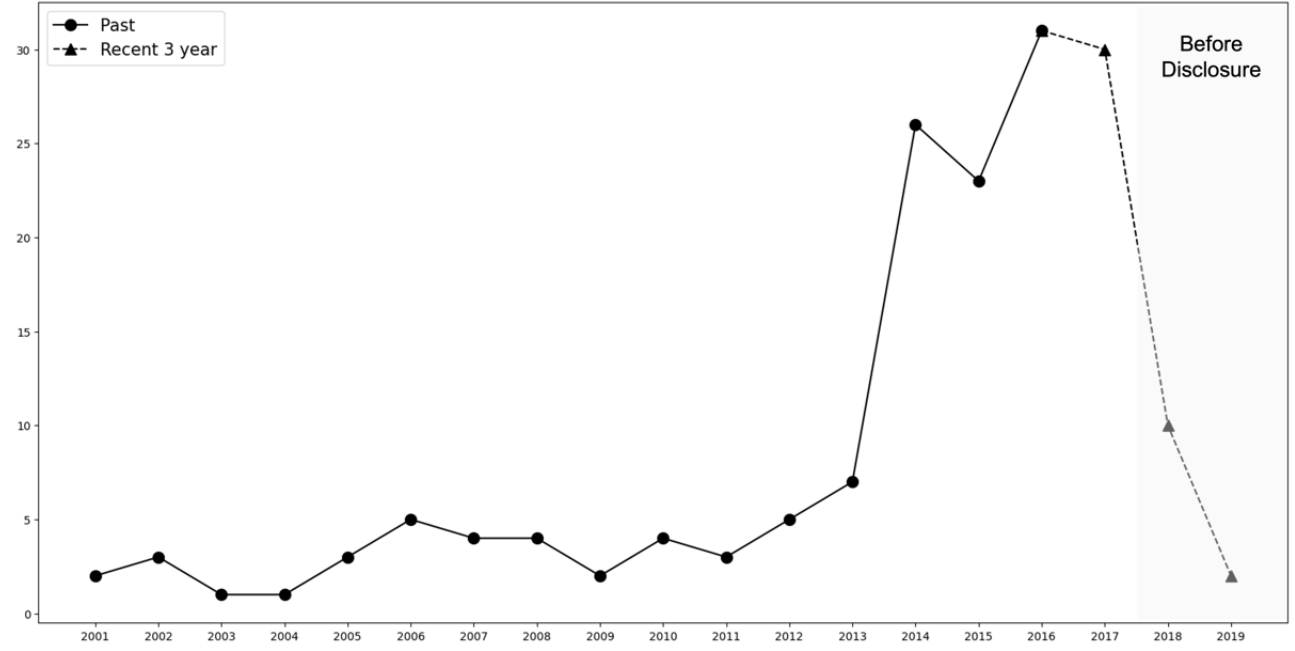
Figure 9. Patent application trends by year based on outliers.